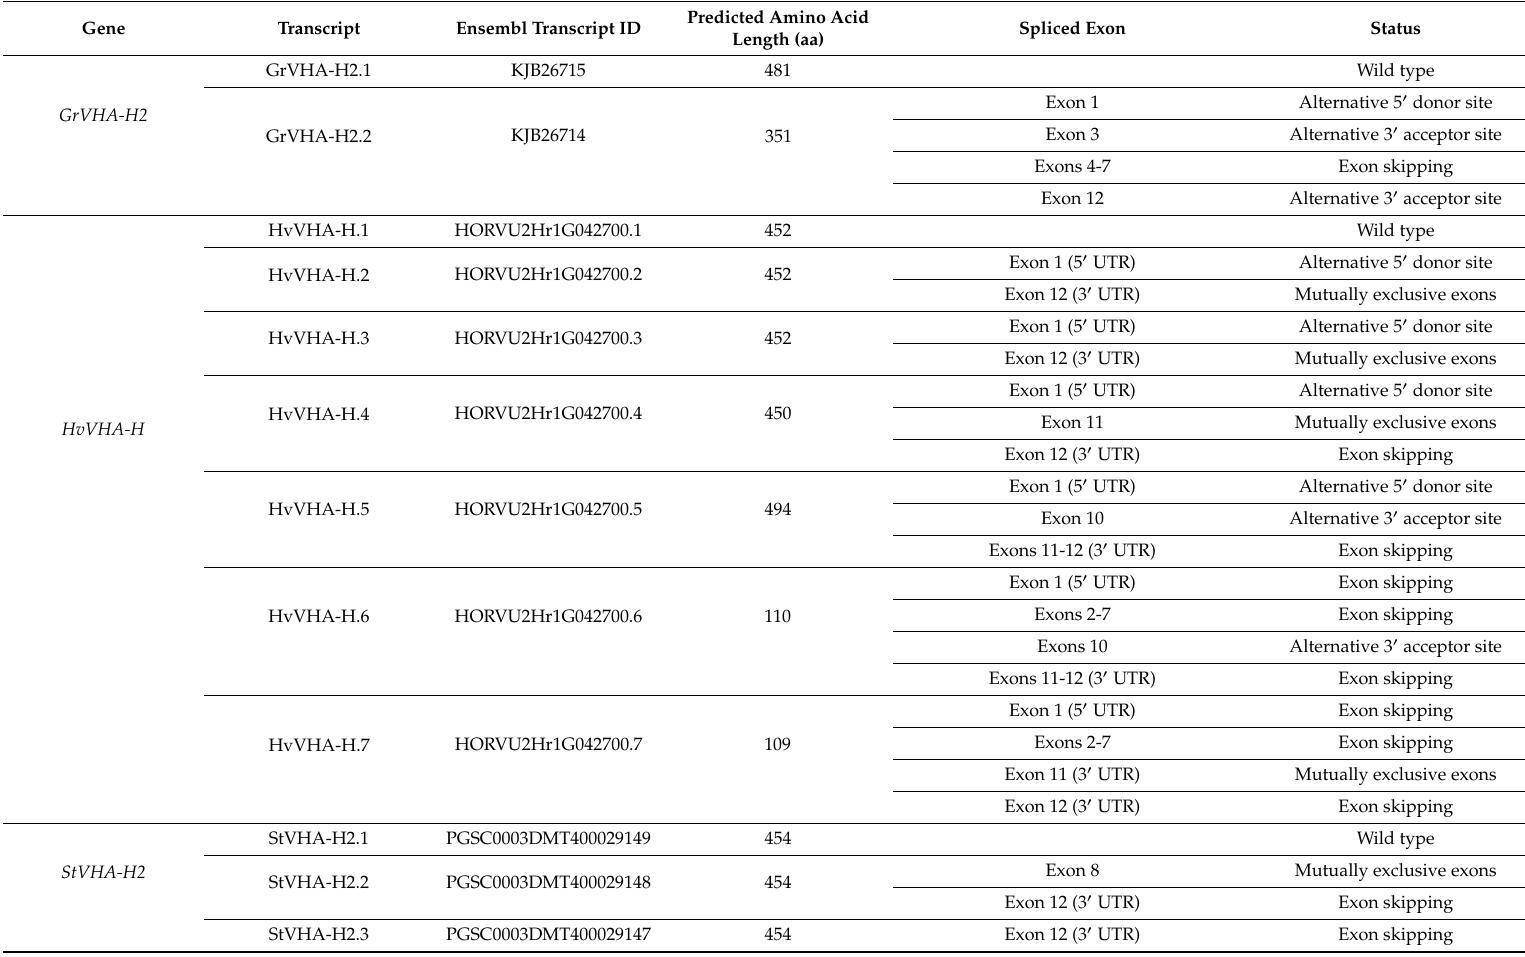
Table 3. Splice variants of 7 VHA-H genes identified in 6 species of crops. Gene names are the same as those in Table 1. Alternative splicing sites occurring in the 5 (cid:48) or 3 (cid:48) UTRs are indicated in parentheses following the spliced